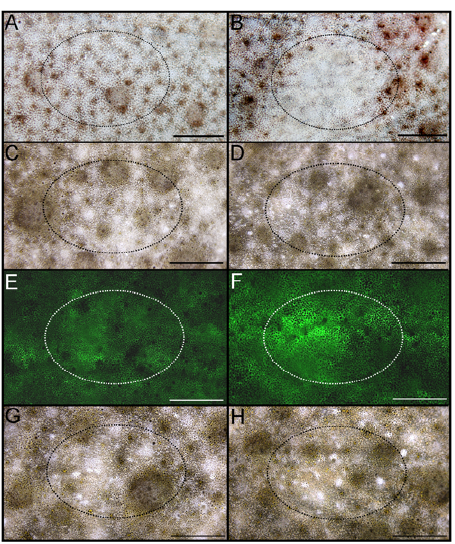
Figure 7. Views of dorsal skin of turbot injected and eletroporated in vivo to evaluate the effect of asip 1 overexpression on skin paling. Animals were injected with about 10 m g of capped sense (B) or antisense (D) mRNA per cm 2 of dorsal skin and the effect was evaluated 4 days post injection/electroporation. Dorsal skin of control non-treated turbots are shown in A, C, E, and G. E and F show dorsal skin of control (E) and injected/electroporated animals with capped sense eGFP-mRNA (F) animals under fluorescent incident light w. G and H display animals shown in E and F under brilliant incident light. . Fluorescence was determined with a binocular Leica Stereoscope M165FC with digital camera (Leica Microsystem). Images were processed with Photoshop 7.0 (Adobe Systems) programs. Dorsal views, anterior to the right. Scale bars: 0.6 cm.